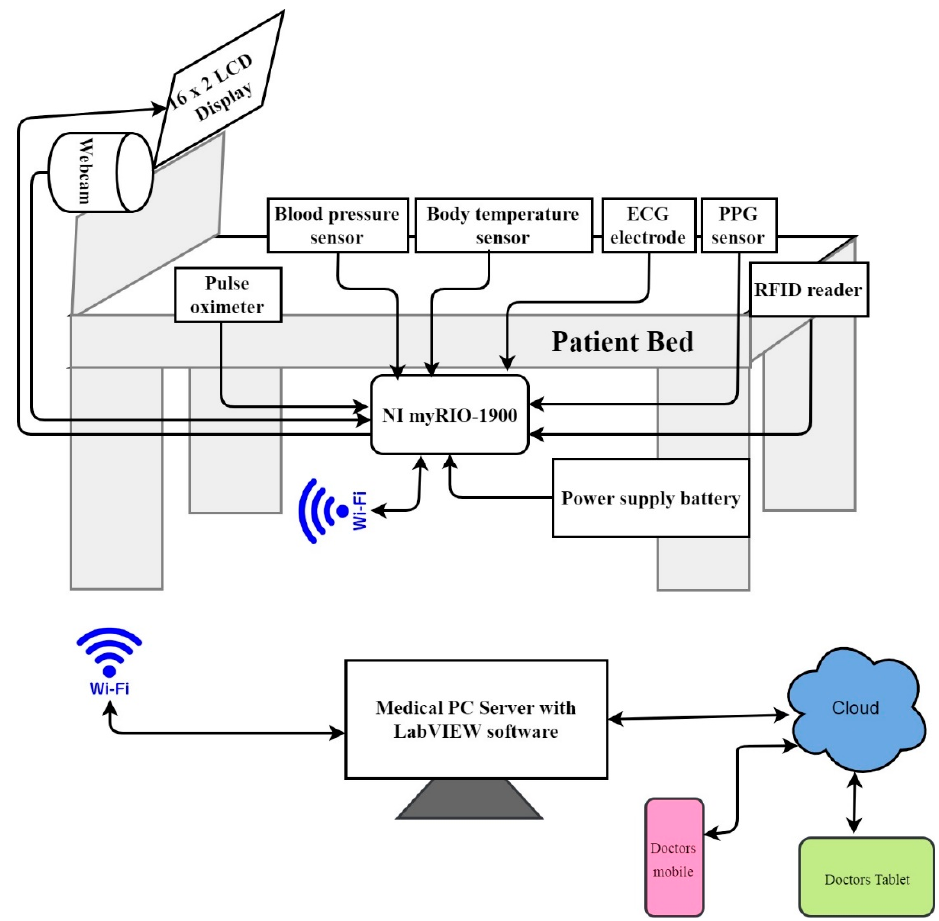
Figure 2. Block diagram of the LI-Care system